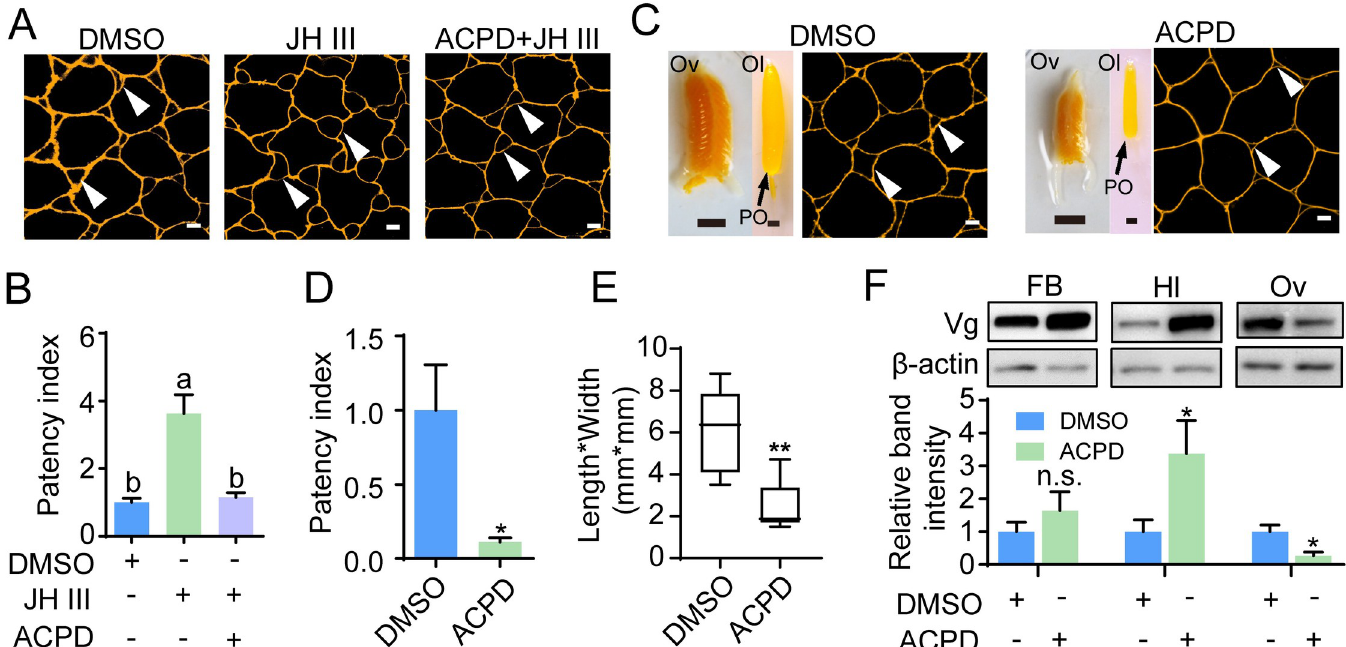
Fig 4. Effect of ACPD treatment on JH-induced patency and vitellogenin transport. (A) Effect of ACPD treatment on JH-induced patency in cultured follicular epithelium isolated from adult females on day 7. Arrow heads indicate patency. Scale bars: 5 μ m. (B) Statistical analysis of patency index in cultured follicular epithelium as represented by Fig 4A. Means labeled with different letters indicate significant difference at P < 0.05. n = 8–10. (C) Effect of ACPD on patency, oocyte maturation and ovarian growth of 7-day-old adult females. Vitellogenic adult females were injected with 40 μ g ACPD once per day from 5 to 7 days PAE and phenotypes were evaluated 6 h after the final injection. Ov, ovary; Ol, ovariole; Po, primary oocyte. Arrow heads indicate patency. Scale bars: ovary, 5 mm; ovariole, 0.5 mm; follicular epithelium, 5 μ m. (D) Statistical analysis of patency index in the follicular epithelium of 7-day-old adult females subjected ACPD injection vs. the DMSO control. � , P < 0.05. n = 8–10. (E) Statistical analysis for the index of primary oocytes of ACPD- and DMSO-treated adult females at 7 days PAE. �� , P < 0.01 when compared to the DMSO control. n = 8–10. (F) Western blot showing the abundance (upper panel) and quantitative analysis of band intensity (lower panel) of vitellogenin proteins in the fat body (FB), hemolymph (Hl) and ovary (Ov) of ACPD - injected adult females vs. the DMSO controls. � P < 0.05 compared to the respective DMSO control. n = 8–10. n.s., no significant difference.